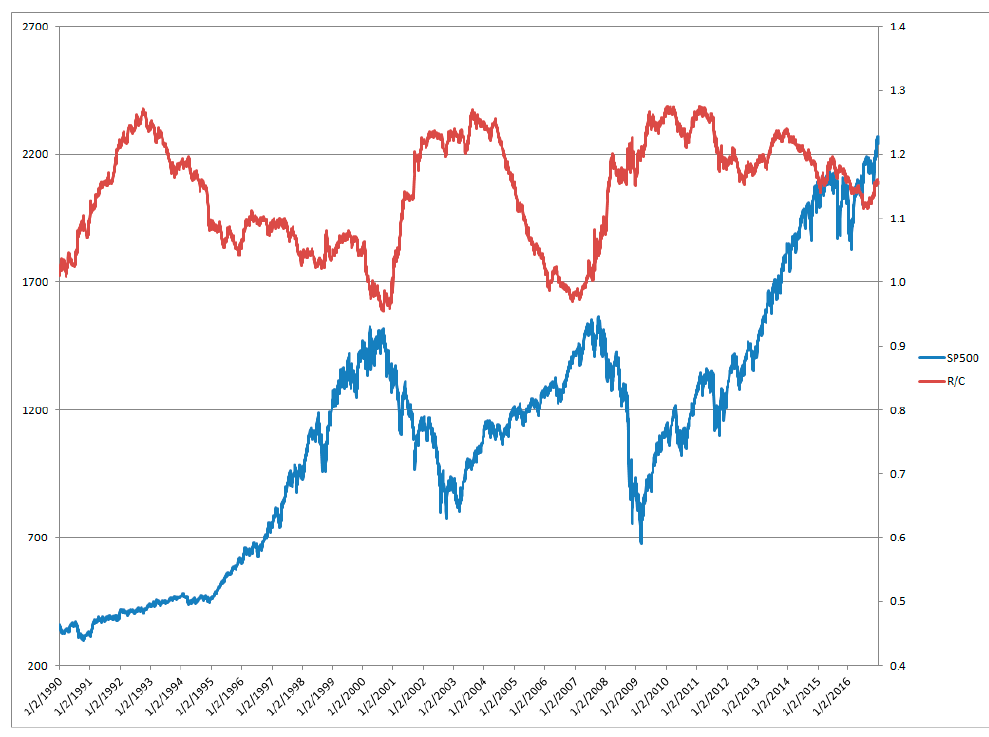
Figure 3. R/C vs SP500